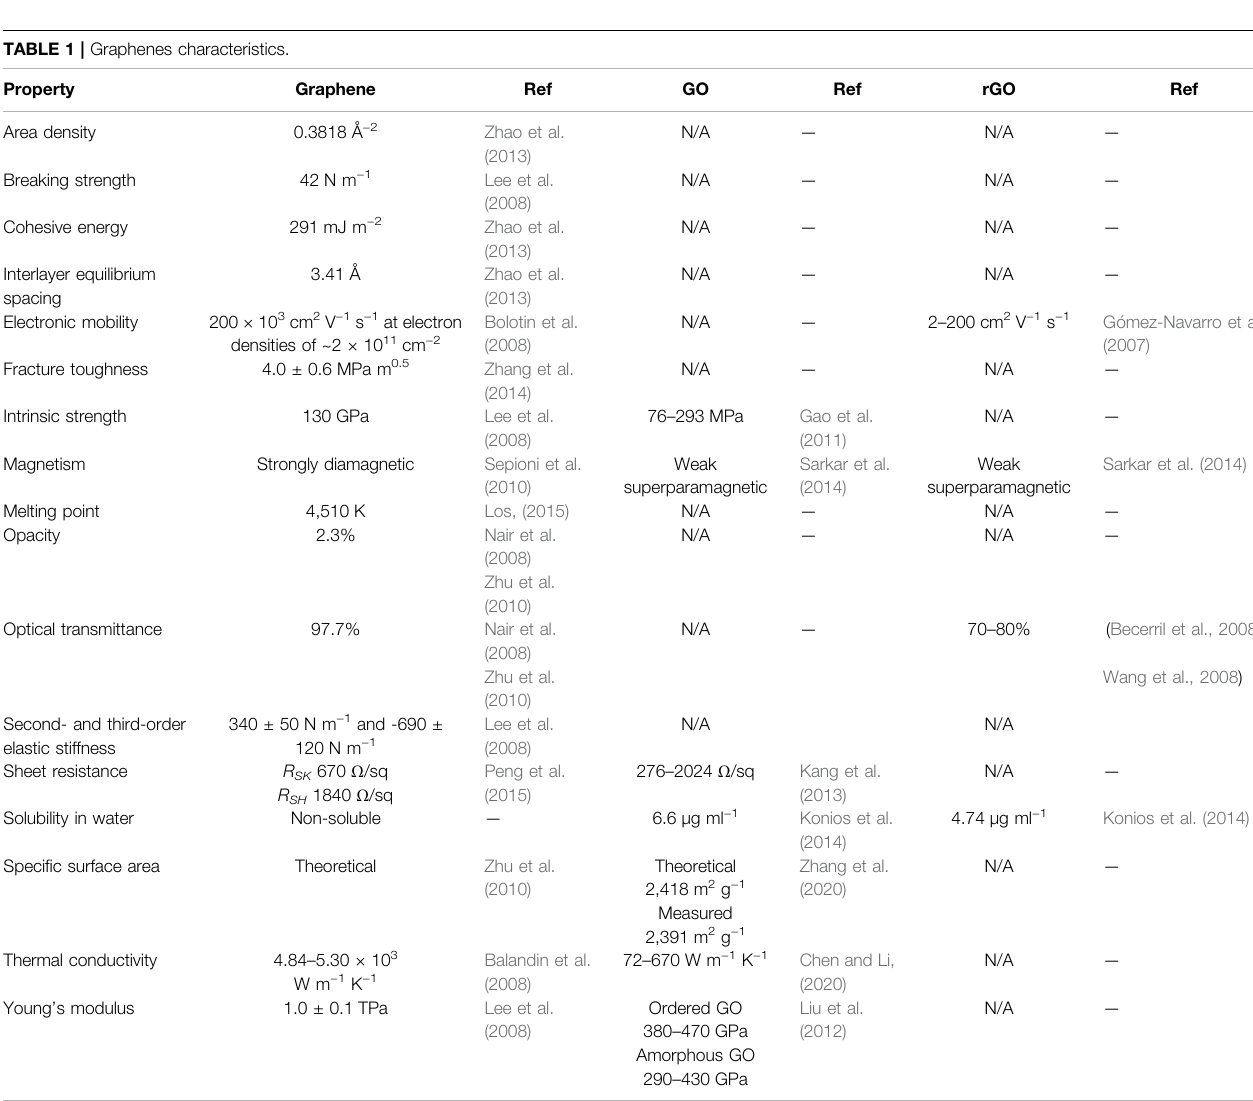
TABLE 1 | Graphenes